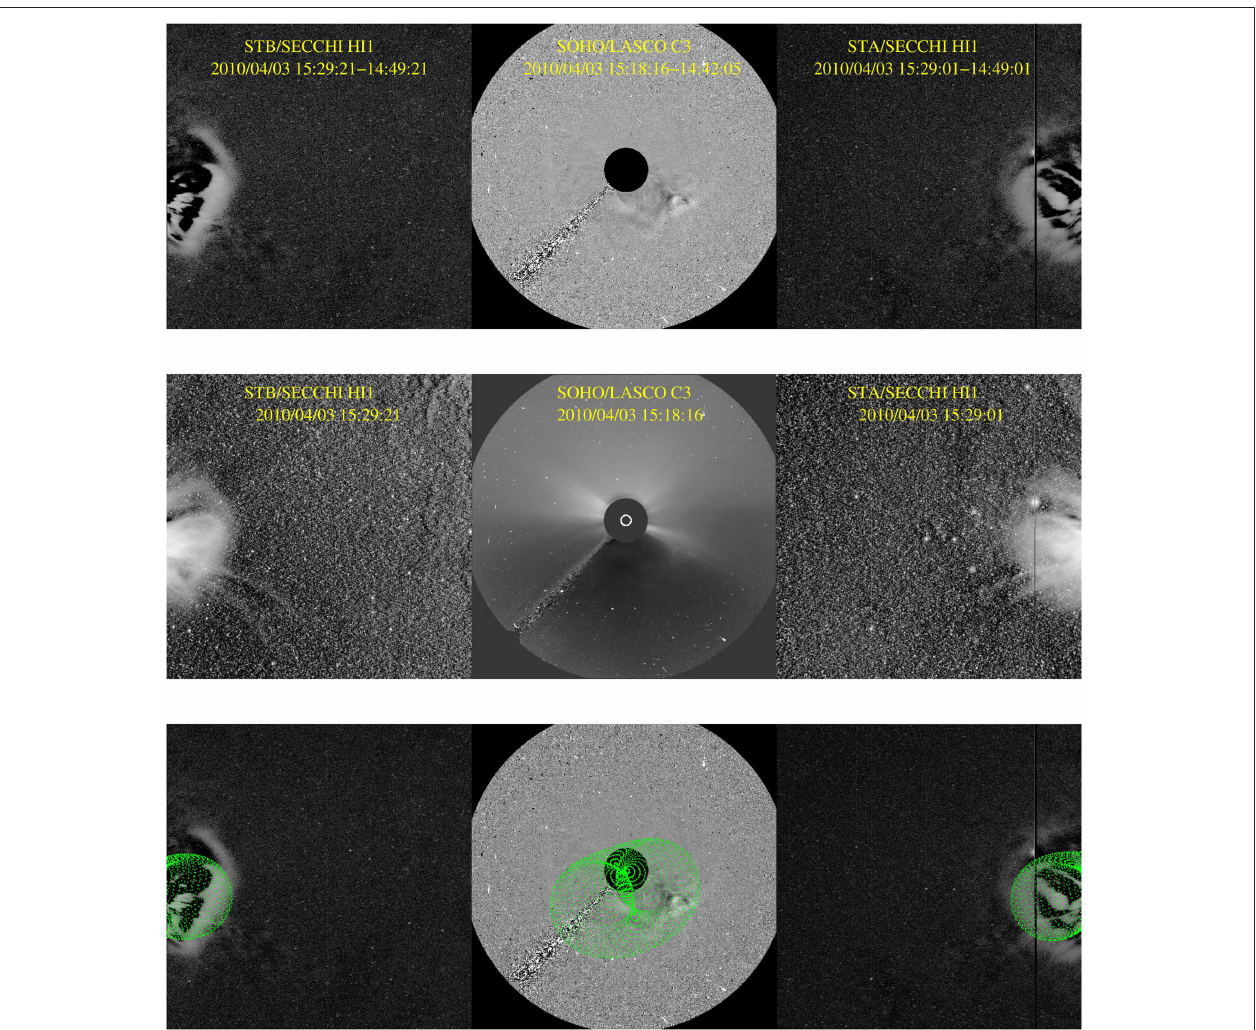
FIGURE 3 | Same as in Figure 2 . In this case, however, the triplet of concurrent images are taken from STEREO /HI1-B (left) , SOHO/LASCO-C3 (middle) , and STEREO /HI1-A (right) around 15:29 UT on 3 April 2010.